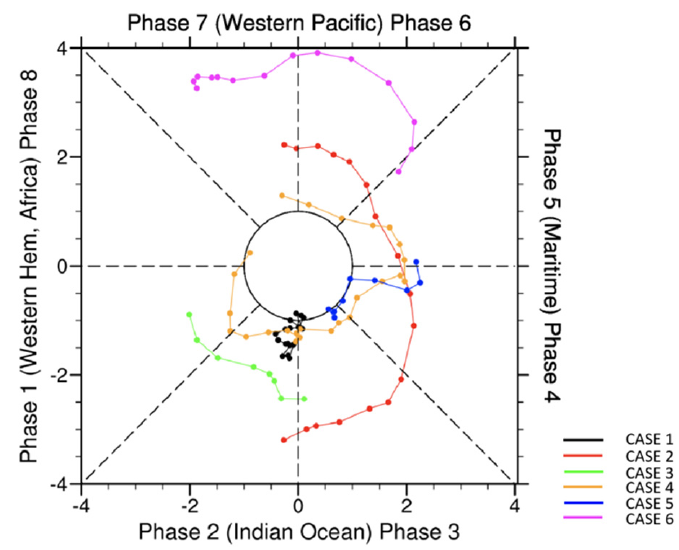
Figure 2. MJO phase and amplitude during the 6 CPEs.